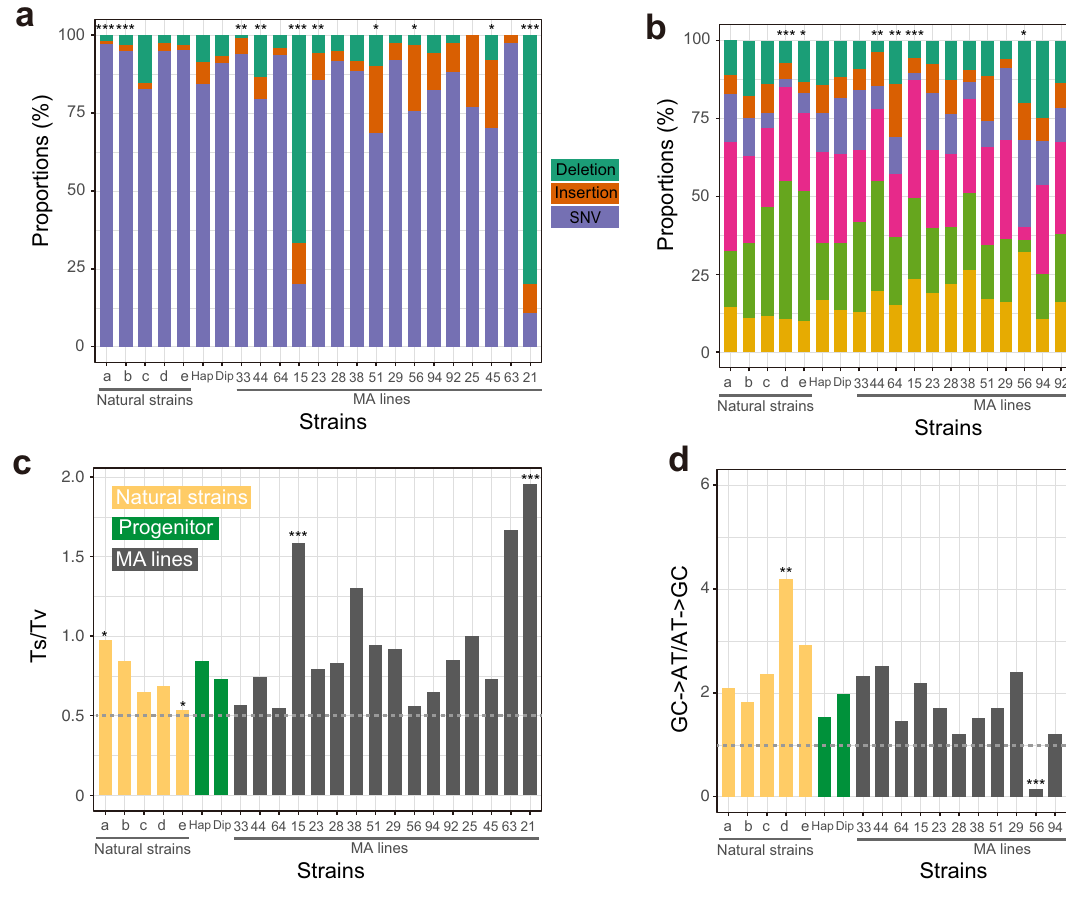
“ Fig. 4 Molecular spectra of mutations in 16 MA lines and 5 naturalyeaststrainsestimatedbyMA+WGS.a ProportionsofSNVs, insertions, and deletions among all mutations. b Relative proportions of the six types of SNVs. c Number of transition mutations relative to the number of transversion mutations (Ts/Tv). d Number of GC → AT mutations relative to the number of AT → GC mutations. In c and d , the gray dotted line shows the random expectation. In all panels, the small